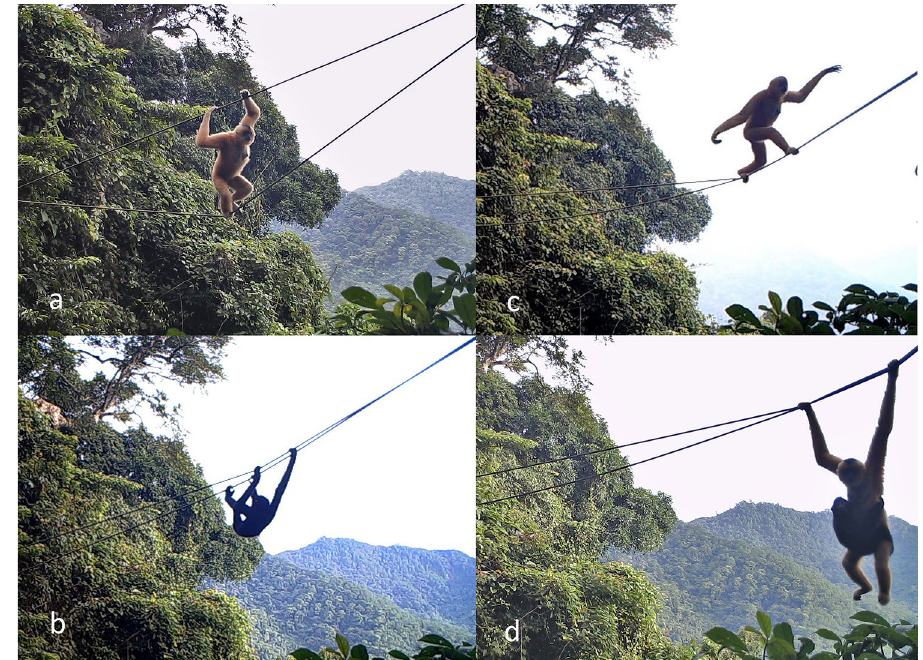
Figure 4. Locomotor modes of Hainan gibbons using a canopy bridge. ( a ) climbing (handrailing); ( b ) climbing (underneath); ( c ) walking; ( d ) brachiation. Camera trap photographs taken by Kadoorie Farm and Botanic Garden.